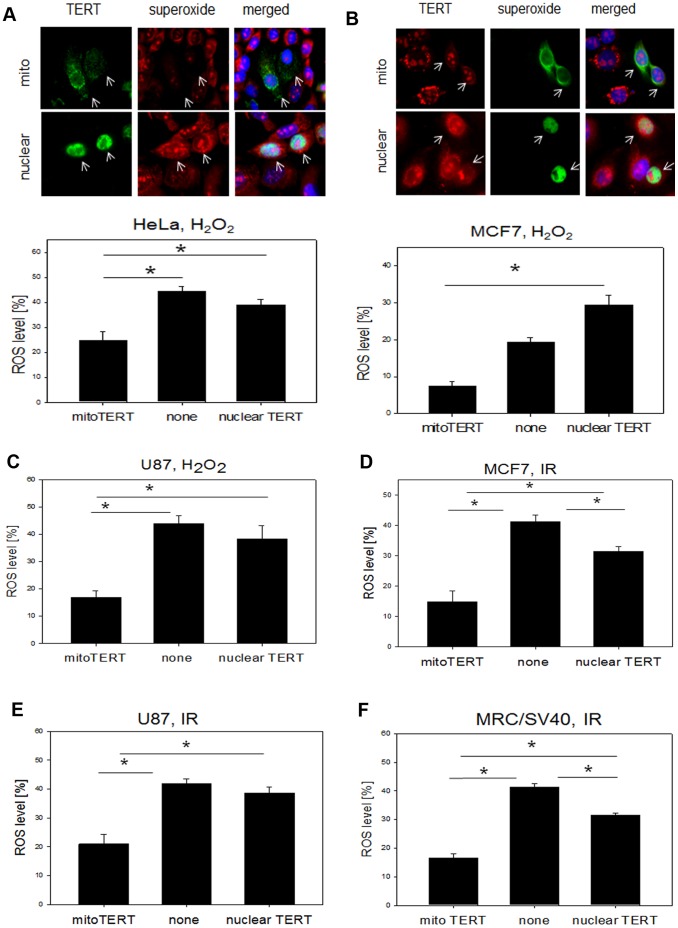
Mitochondrially localized TERT protects against mitochondrial ROS generation after H2O2 treatment and irradiation in 4 different cell lines. A:Upper panel: Representative images of ROS staining (red, mitosox) and TERT localization (myc-tag, green) after organelle specific TERT transfection and 100 µM H2O2 treatment for 3 h in HeLa cells. Upper row: mito- TERT, lower row: nuclear TERT. Arrows indicate transfected cells. Lower panel: Quantification of ROS levels measured as percentage of mitosox positive area from whole cytoplasm using ImageJ in transfected and un-transfected cells. B: MCF7 cells, panels as described for A. C: Quantification of ROS in U87 cells after 3 h of 100 µM H2O2 treatment. D–F: Quantification of ROS levels after X-irradiation. D: MCF7 after 20 Gy X-irradiation. E: U87 after 20 Gy X-irradiation F: MRC-5/SV40 after 10 Gy X-irradiation. Bars represent mean ± SE from 3 independent experiments. * P<0.05.